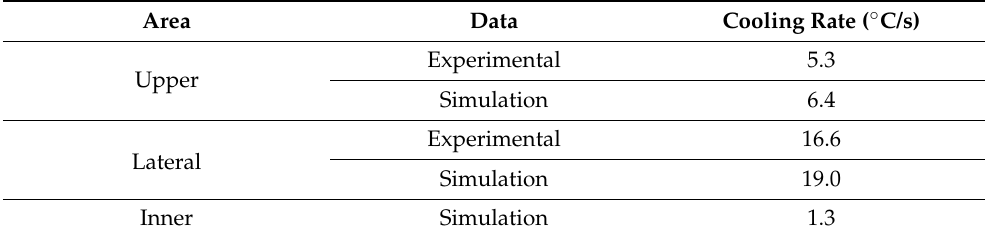
Table 3. Experimental vs. simulated cooling rates for the can from 1115 ◦ C to 1053.4 ◦ C. Area Data